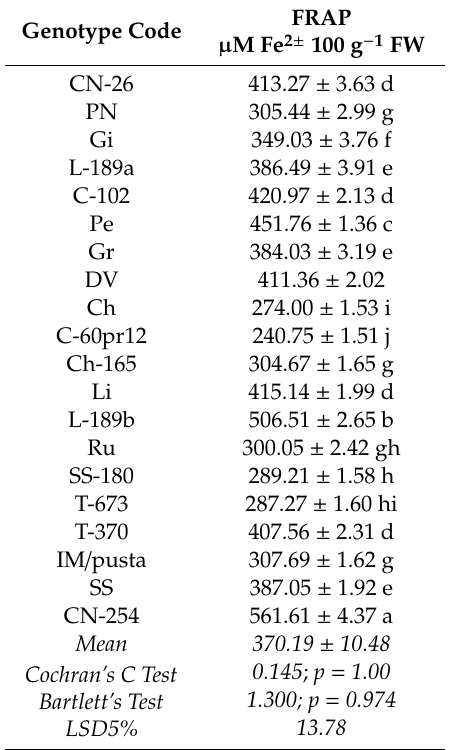
Table 2. Total antioxidant capacity (TAC) of tomato fruit